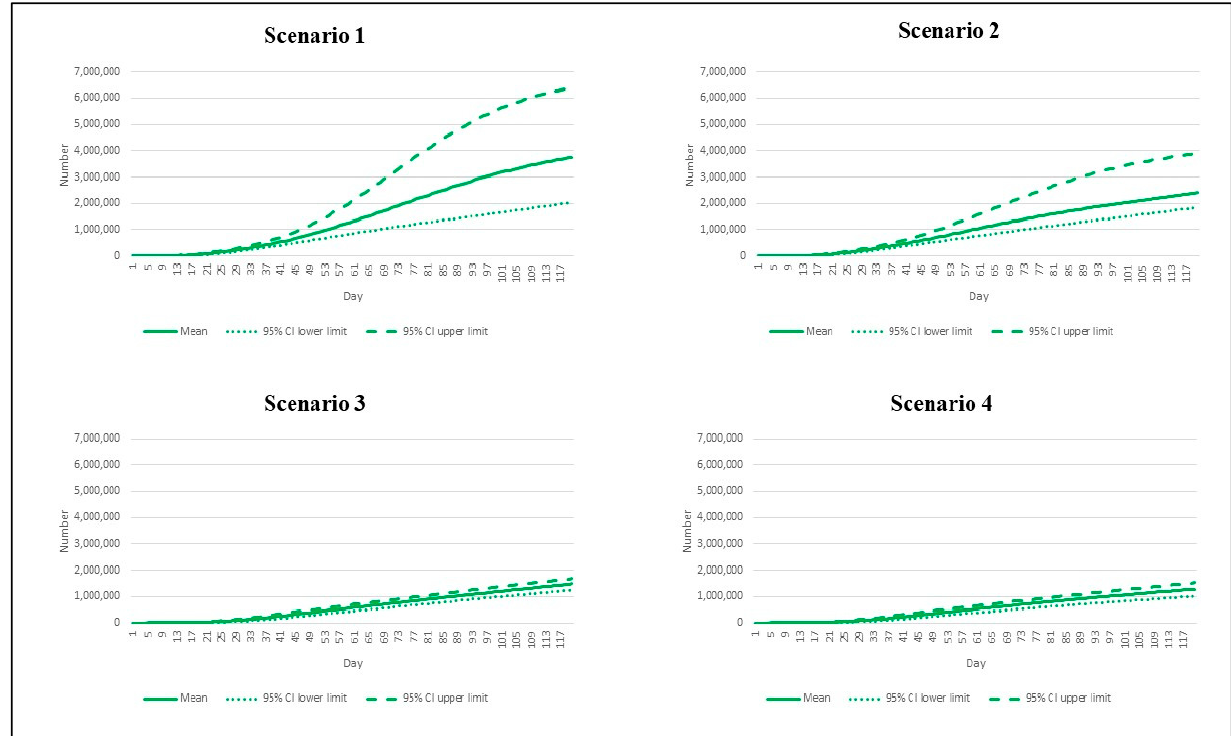
Figure 5. Cumulative case tolls by different epidemic scenarios.